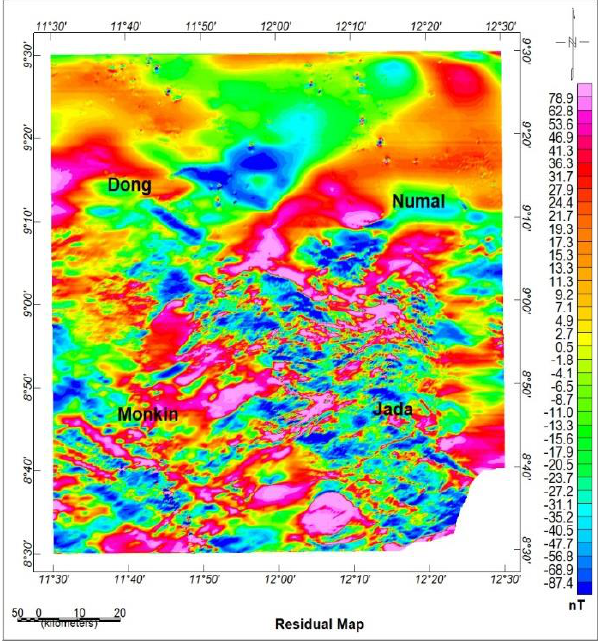
Figure 4: Residual map of the study area